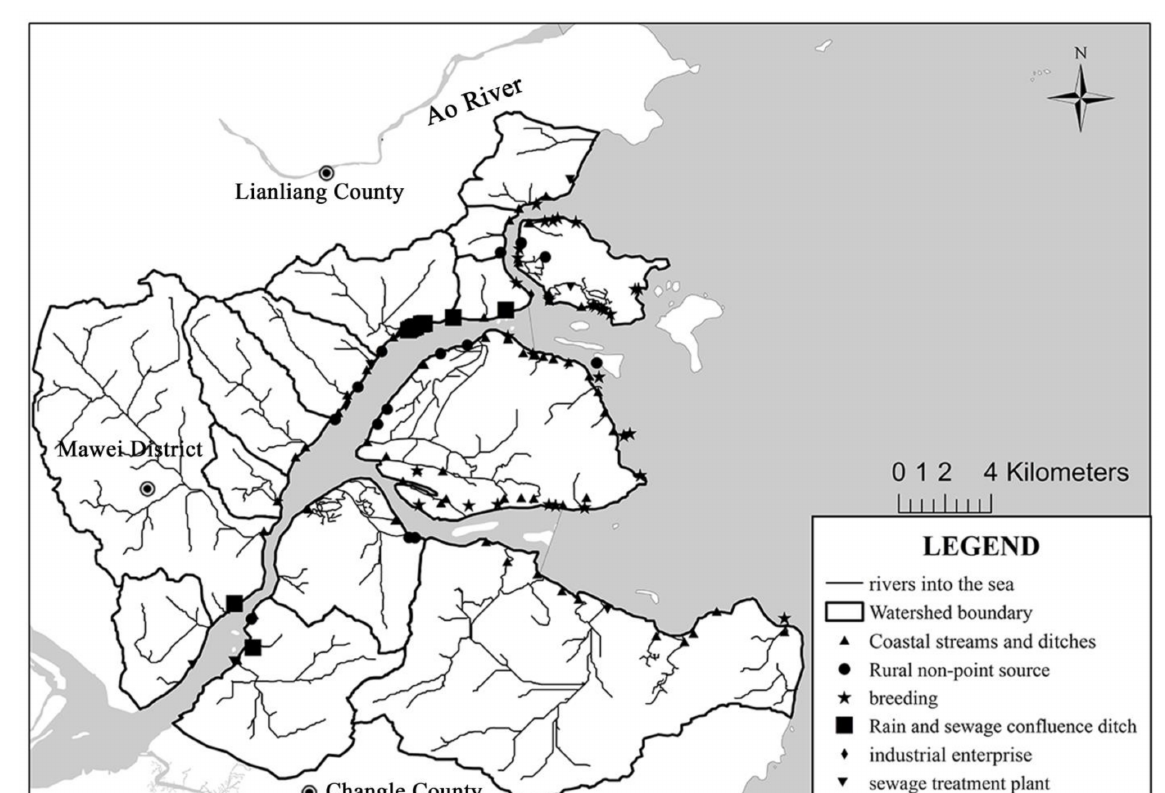
Figure 2. Minjiang Estuary regional catchment area showing the spatial distribution of various types of sewage outfalls after